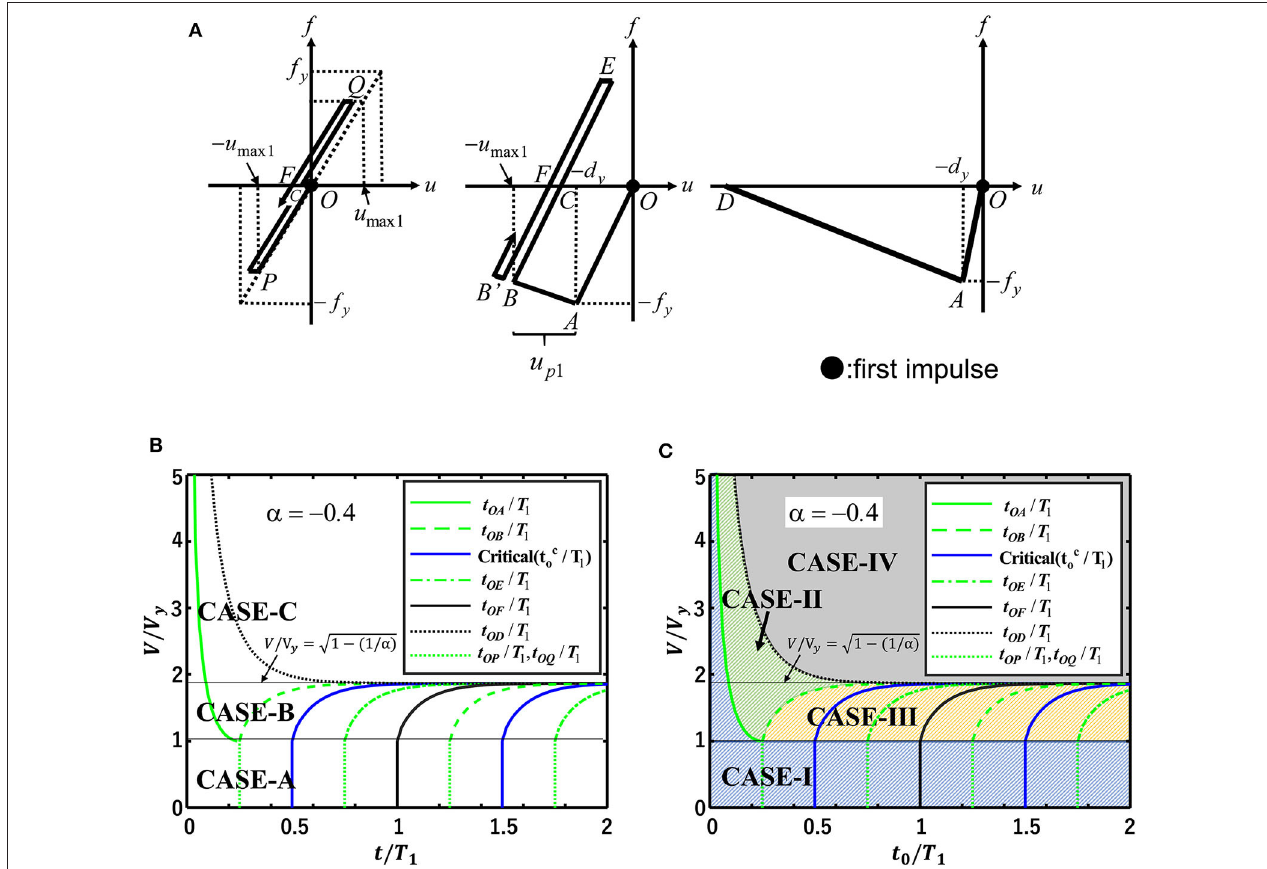
FIGURE 3 | Classification based on input level of double impulse and timing of second impulse. (A) Force–deformation relation depending on input level of double impulse. (B) Classification based on input level of double impulse and time between origin O and principal points. (C) Classification based on timing of second